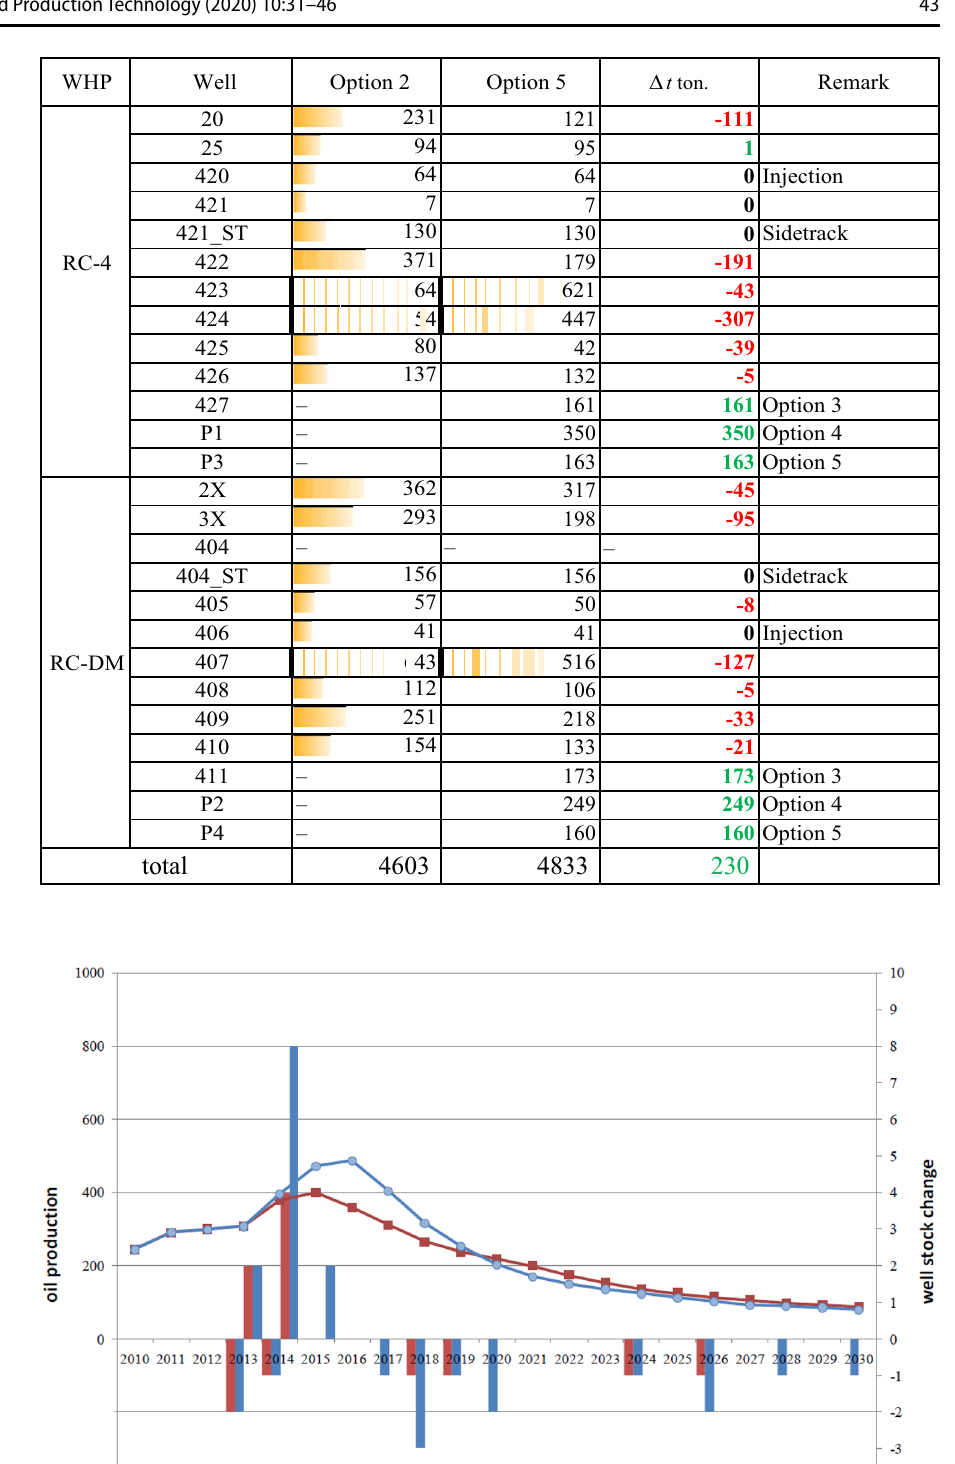
Table 4 Comparison of the predictive specific oil production of wells